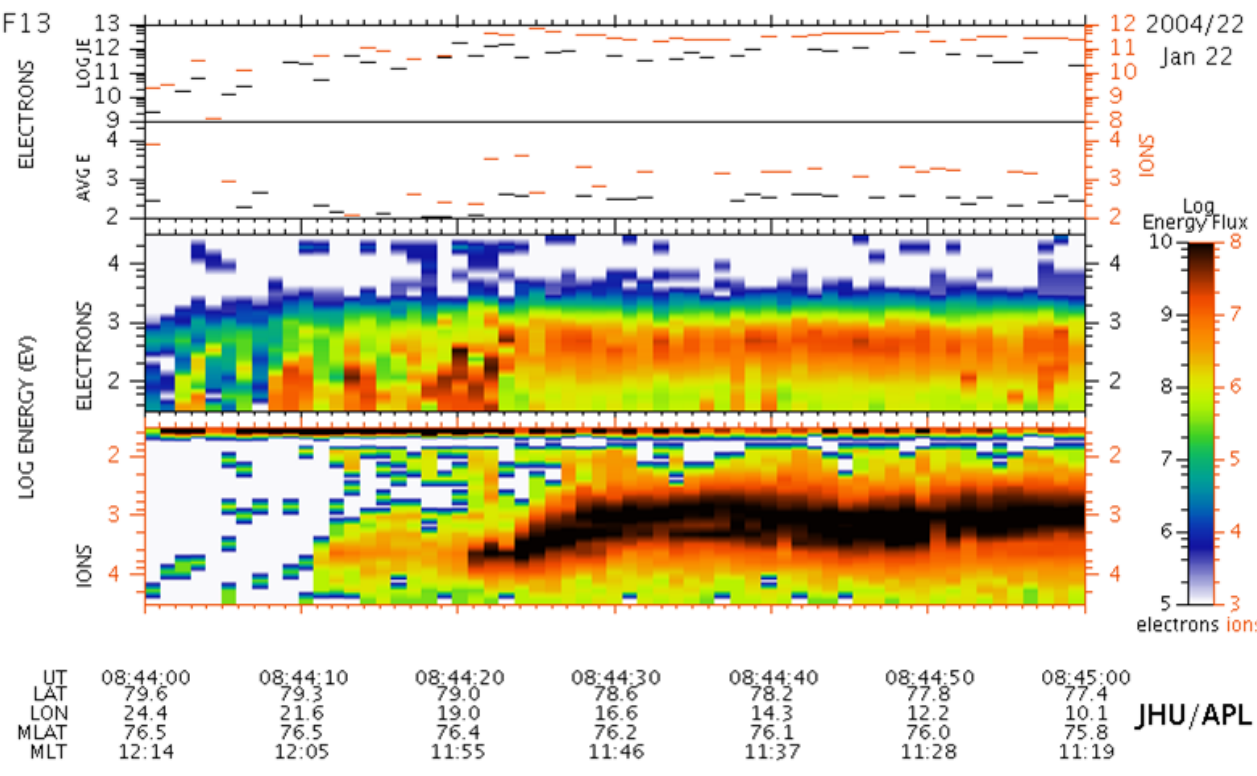
Fig. 10. DMSP spectrogram from the F-13 satellite, for the interval 08:44UT to 08:45UT.